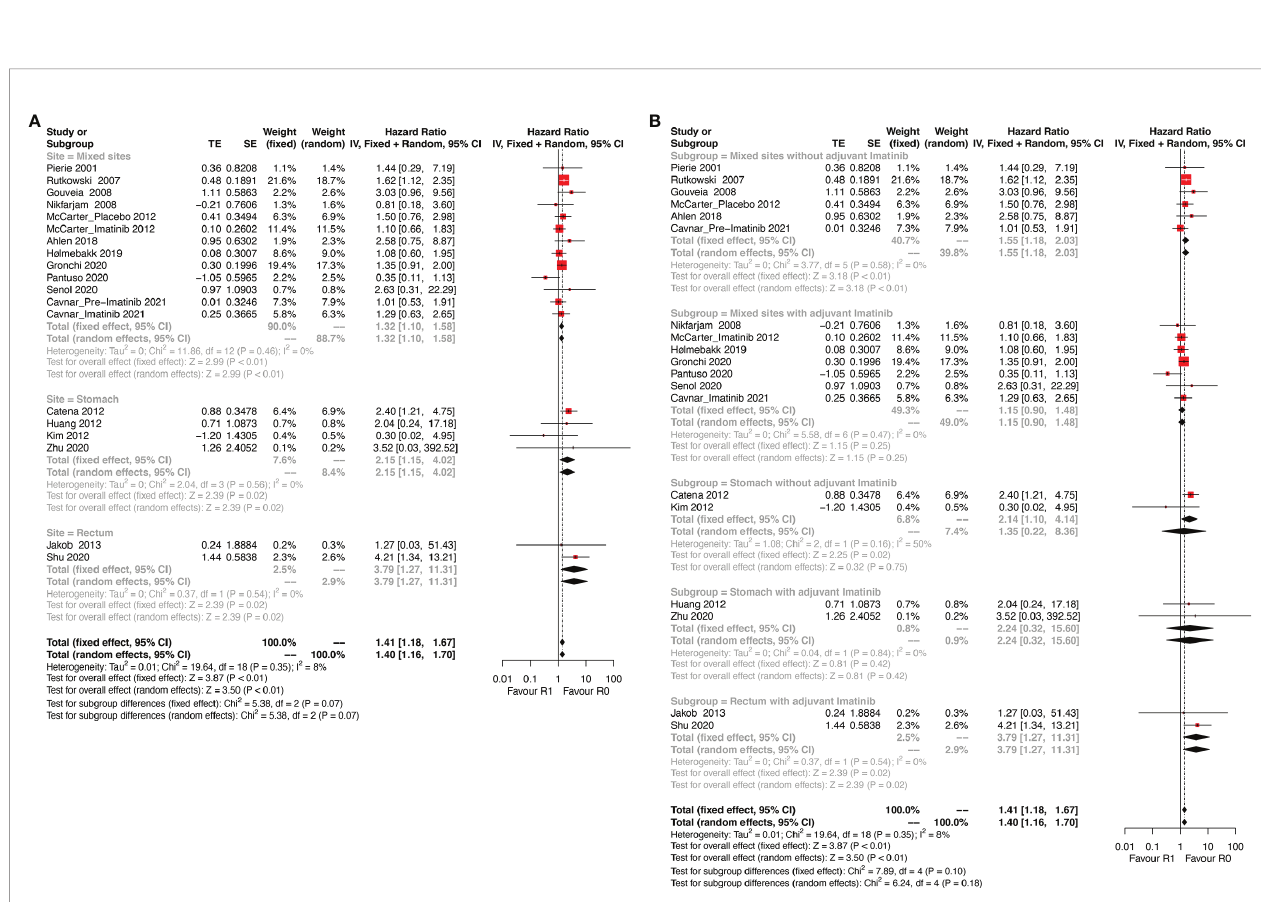
FIGURE 2 | Forest plots illustrating disease-free survival between R1 and R0 margins. Subgroup analysis according to (A) study type and (B) use of